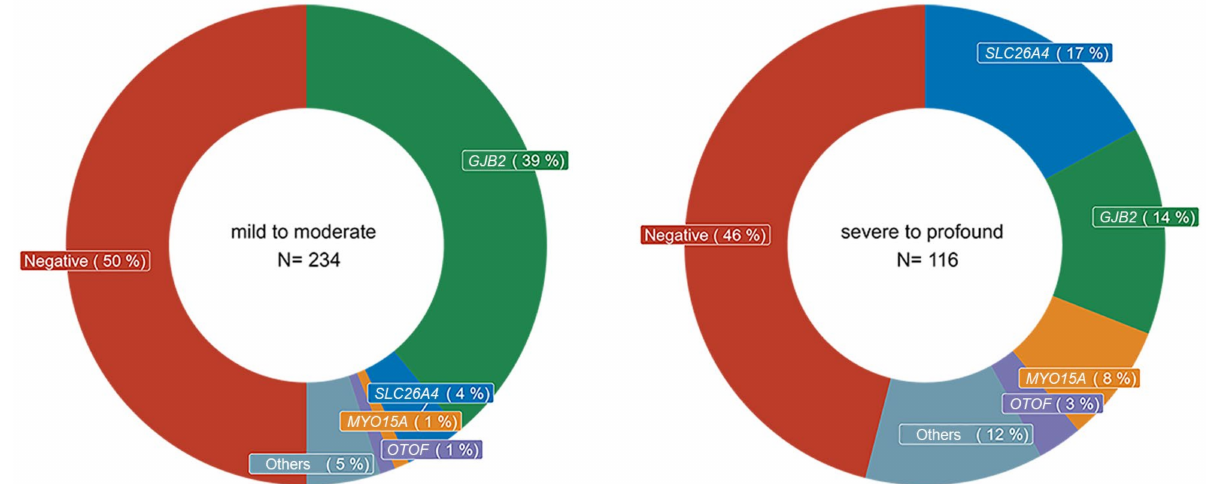
Figure 1. Genetic etiologies by severity of sensorineural hearing impairment (SNHI). The most commonly affected gene was GJB2 in patients with mild-to-moderate SNHI, while SLC26A4 , MYO15A , and OTOF were more commonly associated with severe-to-profound SNHI. The rates of negative results for genetic testing were similar regardless of the severity of SNHI.